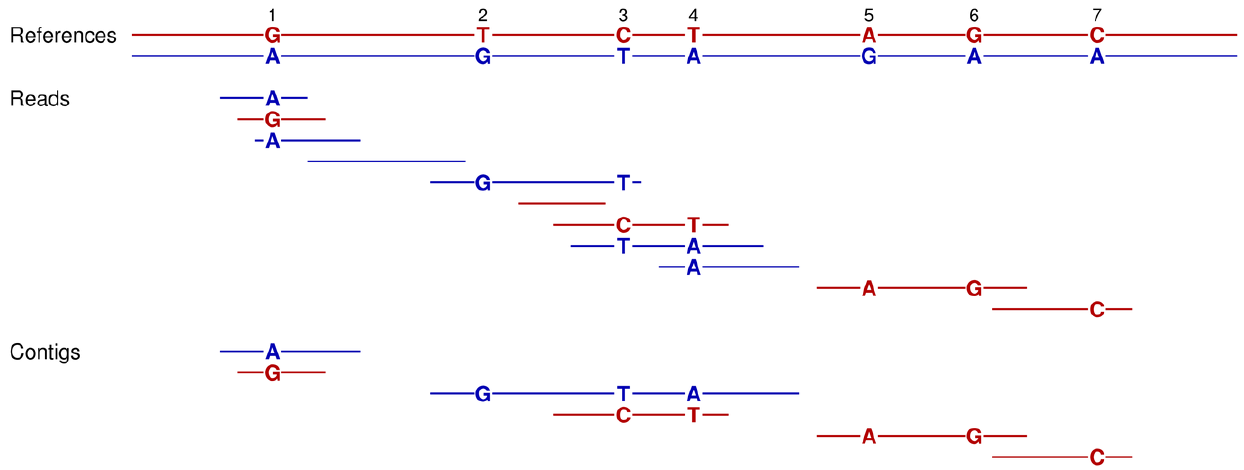
Figure 4. How our assembly simulator can determine the phase of the linked heterozygous sites from the reads for a diploid individual. A standard assembly simulation is performed for the 11 reads of the red versus blue homologous references of a single diploid. Those reads that do not cover any of the seven polymorphic sites are discarded, since they can be mapped to either the red or blue reference (e.g., reads four and six). Similarly, those reads with overlaps that do not include a polymorphic site are left unconnected, since their overlapping sequences can be mapped to either the red or blue reference (e.g., the last two reads). In contrast, the other reads with overlapping polymorphisms can be assembled into contigs, since their overlaps can be mapped by their different heterozygous bases to either the red or blue homolog, but not both (e.g., reads one and three). The final contigs allow for the determination of phase (haplotypes) for heterozygous sites 2, 3, and 4 and for positions 5 and